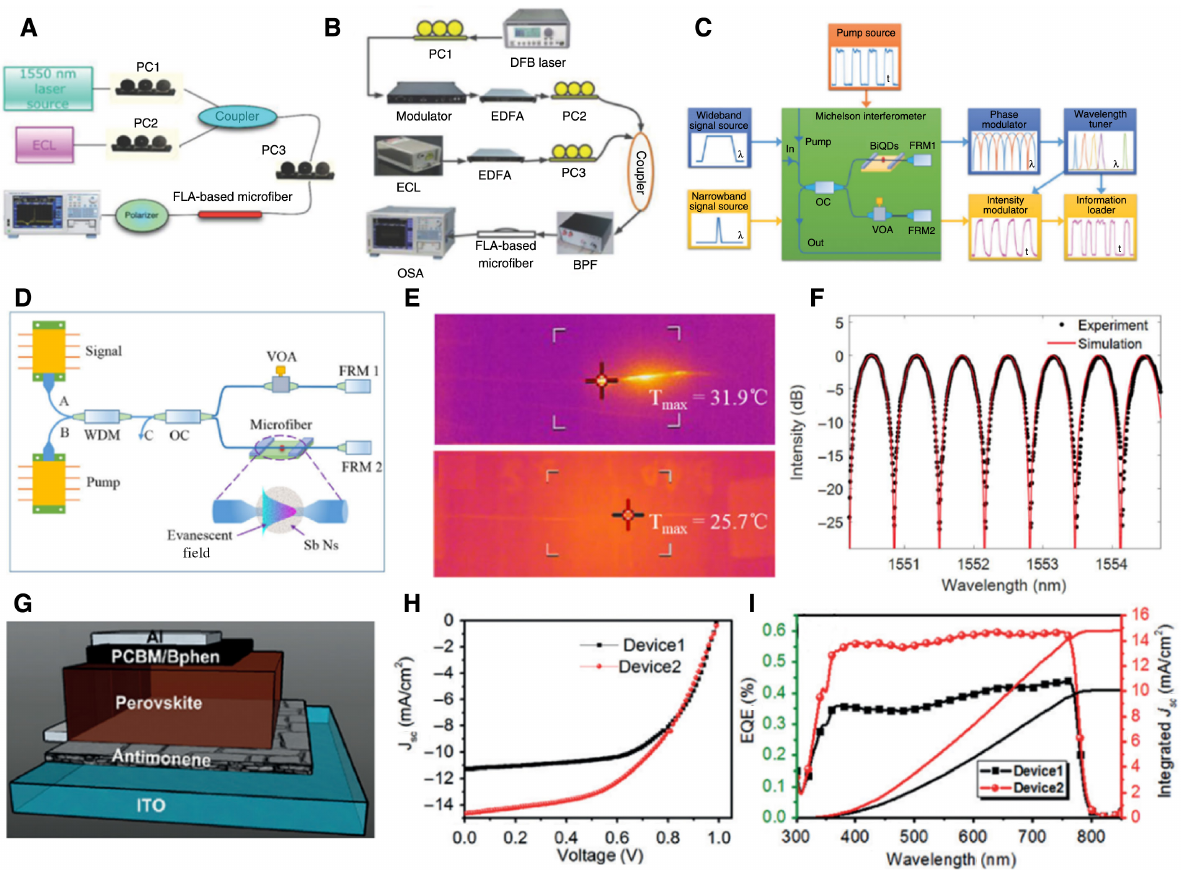
Figure 8: The performance of antimonene- and bismuthene-based microfiber, converer, modulator, and solar cell. (A) Schematic illustration of the Kerr switcher based on antimonene-decorated microfiber. (B) Schematic illustration of a four-wave mixing wavelength converter based on the antimonene-decorated microfiber. Reproduced with permission [118]. Copyright 2018, John Wiley and Sons. (C) Module diagram of the all-optical modulator based on few-layer bismuthene. Reproduced with permission [110]. Copyright 2019, The Royal Society of Chemistry. (D) Experimental setup of the antimonene-based all-optical modulator (AOM). (E) Infrared thermograms of microfibers with (top) and without (bottom) antimonene-decorated. (F) Interferometric spectrum of the antimonene-based AOM. Reproduced with permission [125]. Copyright 2019, John Wiley and Sons. (G) The configuration of the perovskite solar cell device used antimonene as the hole transport layer (HTL). (H) The comparison of current density-voltage ( J - V ) curves for perovskite solar cells with (Device 2) and without sc (Device 1) antimonene-based HTL. (I) EQE and integrated short-circuit current densities ( J ) as a function of incident light wavelengths for sc device 1 and device 2. Reproduced with permission [86]. Copyright 2018, John Wiley and